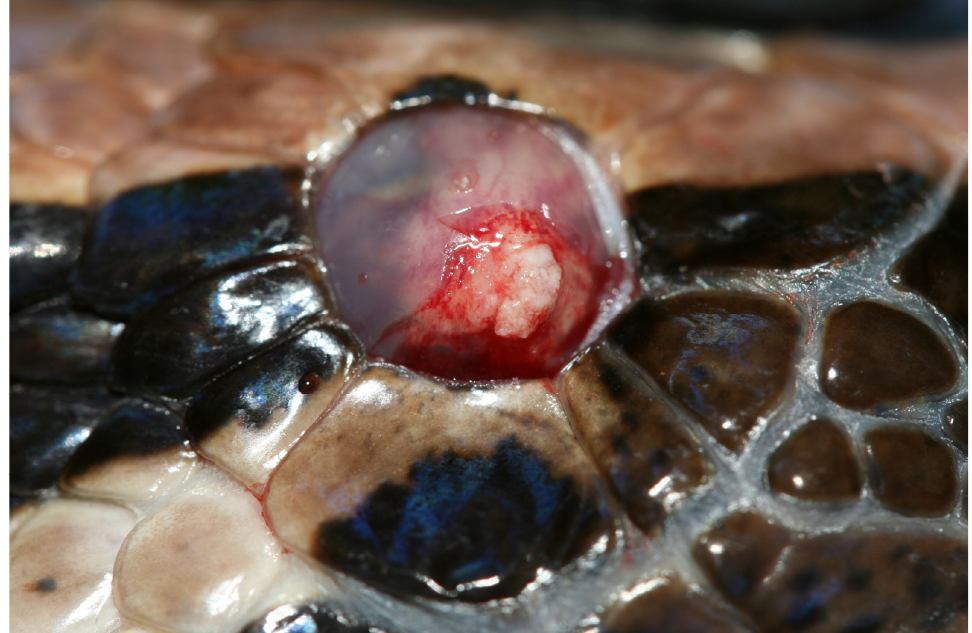
Figure 39. Partial spectaculectomy in a Burmese python ( Python bivittatus ) with a subspectacular abscess allows removal of the exudate from the subspectacular space. Once the wedge has been created, the debris can be removed if complete aspiration was not feasible and topical antimicrobial administration can be performed.